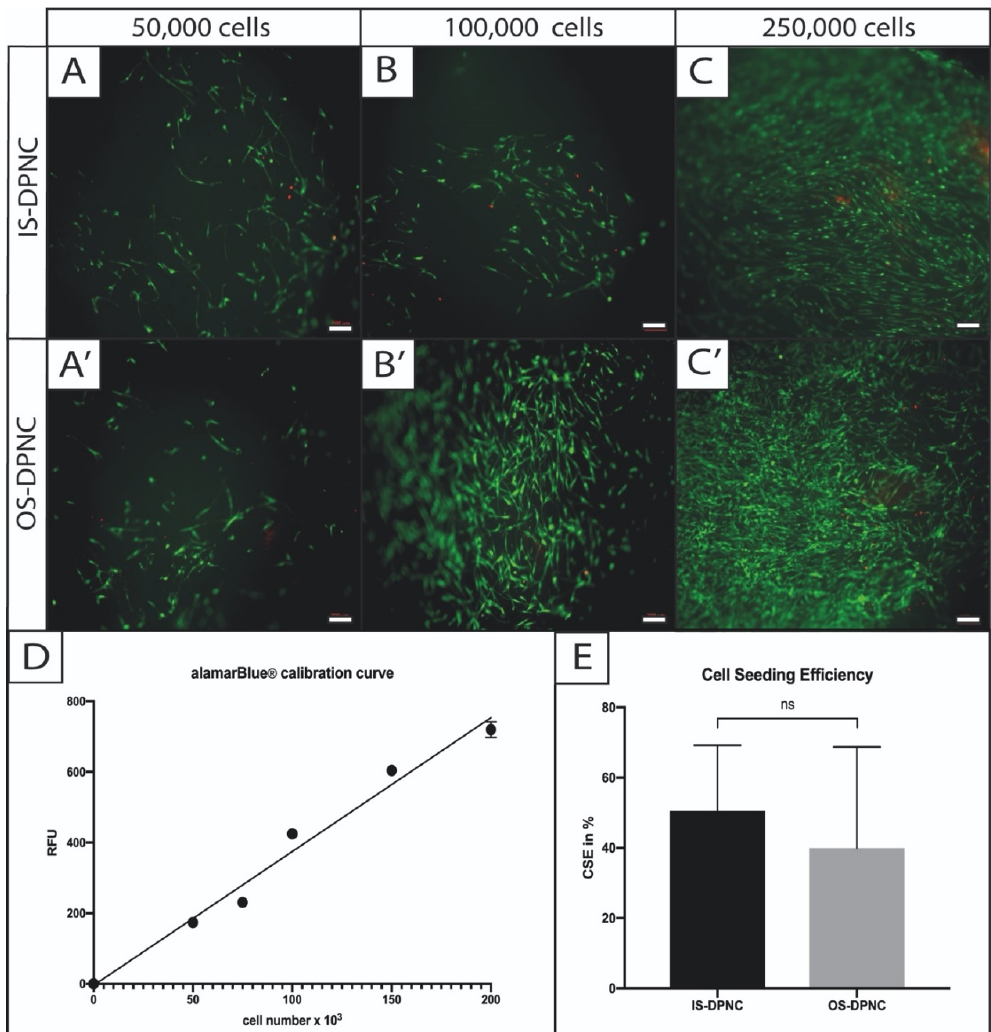
Figure 2. Cell seeding visualization and calculation of efficiency on different DPNC zones. ASCs were statically seeded in different concentrations on IS ( A – C ) or OS ( A ’– C ’) and were visualized by Live–Dead assay 4 h later. Vital cells were stained in green (FDA) and dead cells in red (PI). No difference in cell vitality was observed between DPNC zones and cell seeding concentration (bar = 200 μ m). For the calculation of cell seeding efficiency, a calibration curve (r 2 = 0.98) was used to indirectly calculate the CSE through comparison with the MMA of defined cell numbers in 2D ( D ). CSE ( E ) revealed no significant difference ( p = 0.3) between IS and OS (n = 5; ns = not significant; mean ± SD).